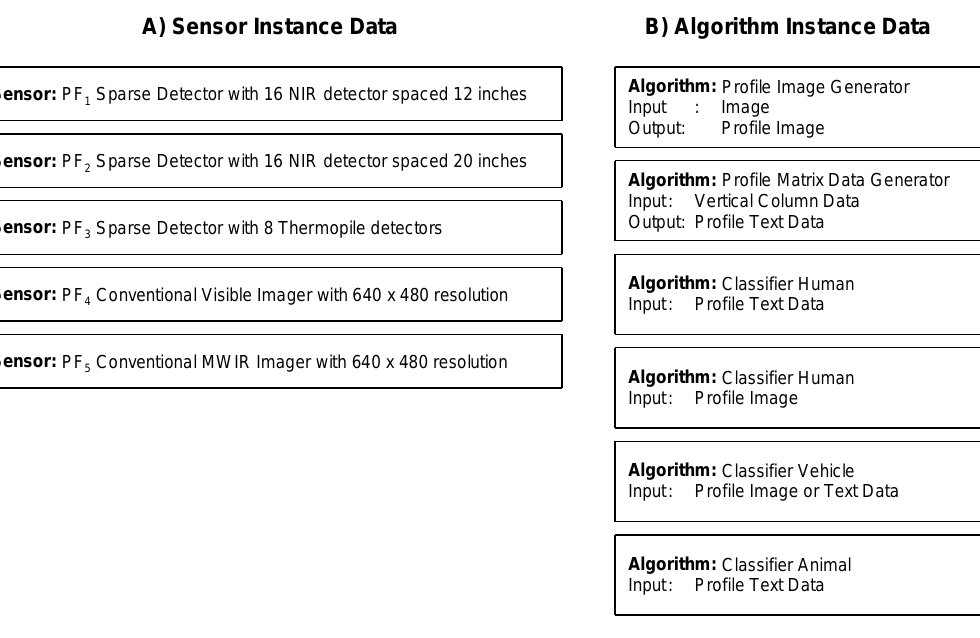
Figure 20. Example instances: (a) Three PFx sensors and two conventional imaging sensors. (b) Two profile generators and four classifiers.